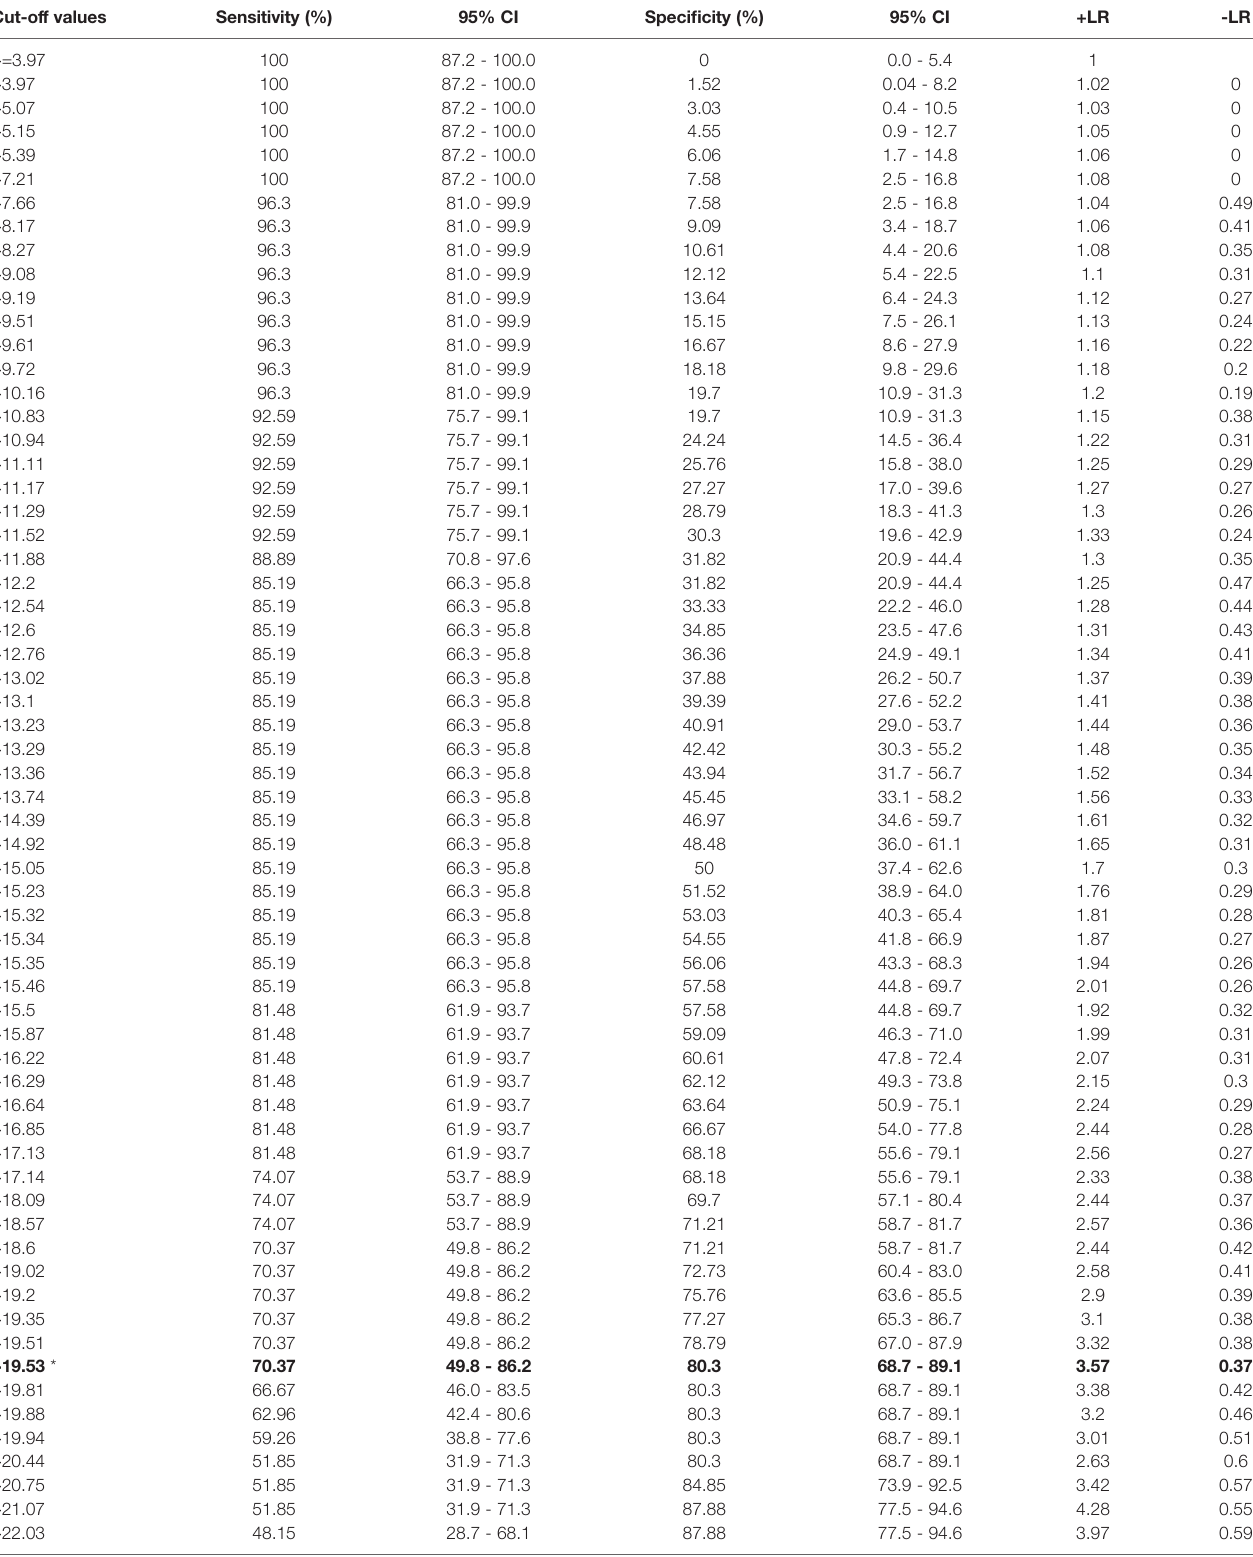
TABLE 5 | Performance of baseline LS value in predicting PD in training set (n = 93). Cut-off values Sensitivity (%) 95% CI Speci fi city (%) 95% CI +LR -LR >=3.97 100 87.2 -